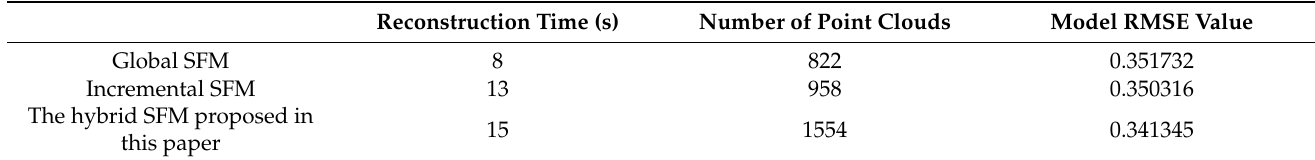
Table 1. Dataset “wallet” experimental data.